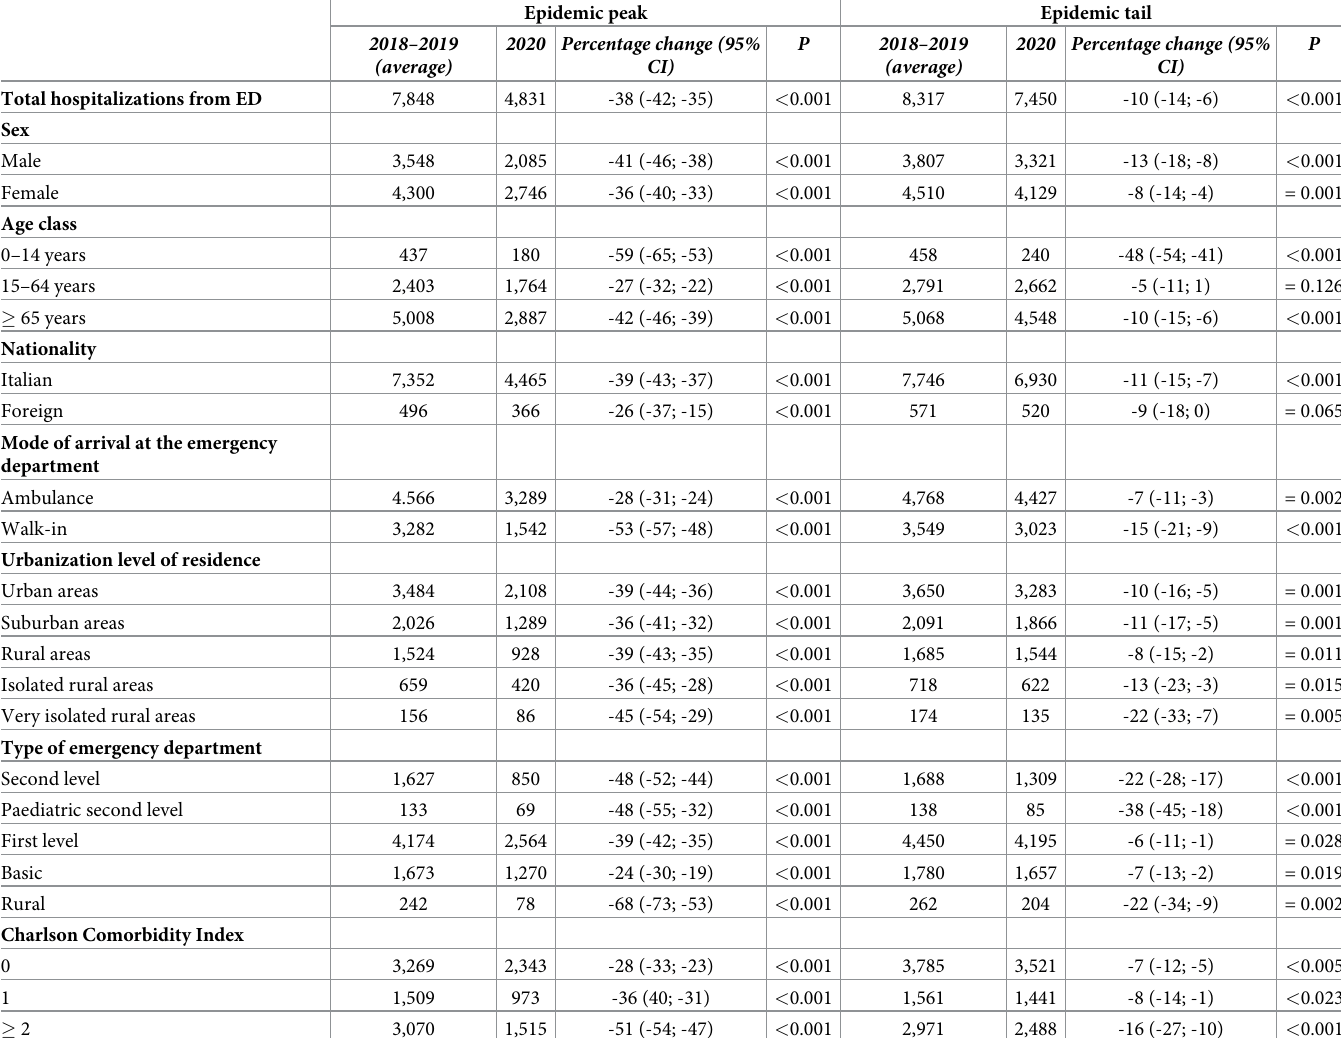
Table 2. Hospitalizations from the emergency department (ED) in 2020 during the two considered epidemic periods (peak and tail) vs average hospitalizations from ED in 2018–19; percentage changes and 95% CIs (Poisson regression